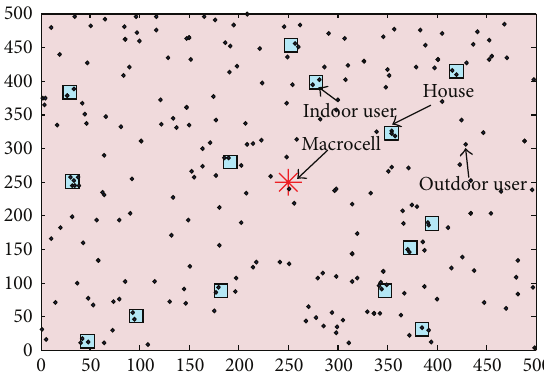
Figure 2: Sample layout of the